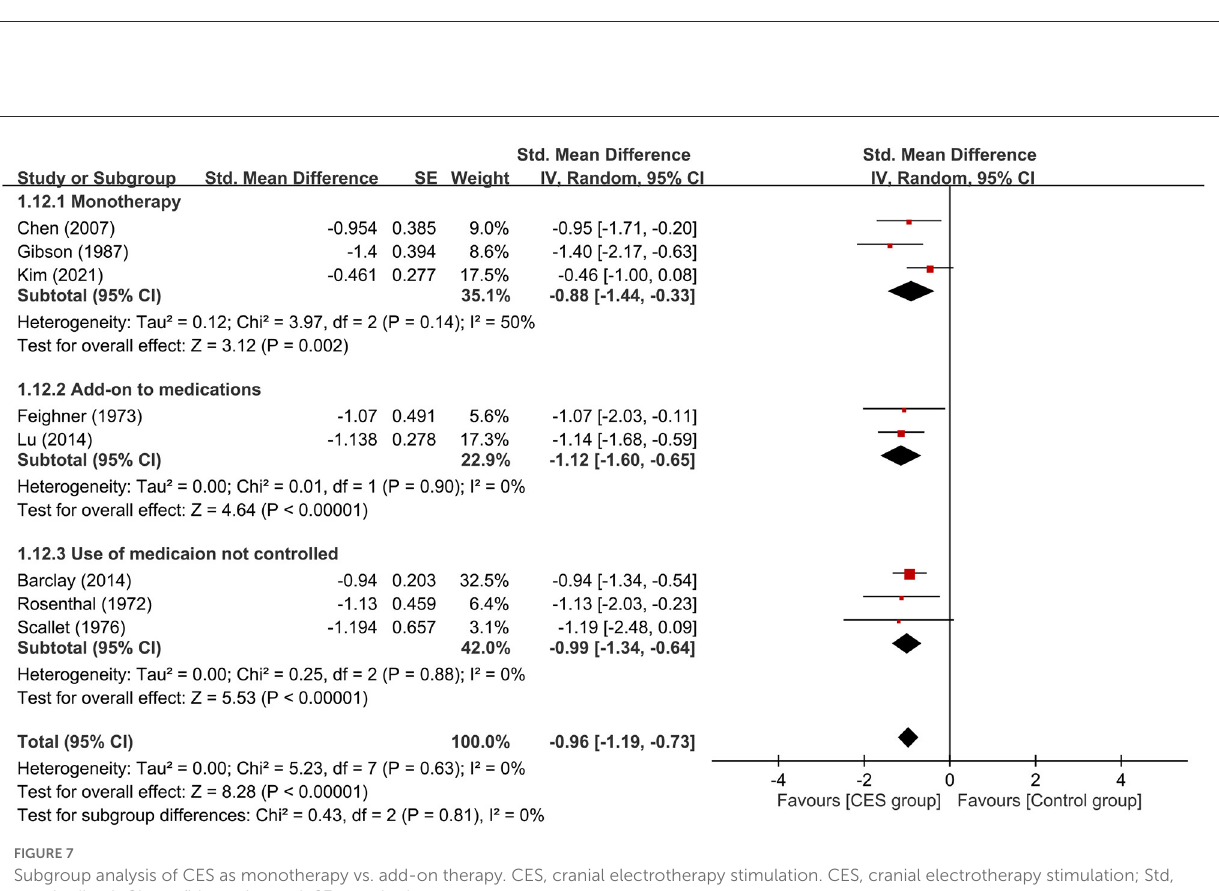
FIGURE6 Subgroup analysis of patients with anxiety alone or those with anxiety combined with depressive symptoms. CES, cranial electrotherapy stimulation; Std, standardized; CI, confidence interval; SE, standard error.